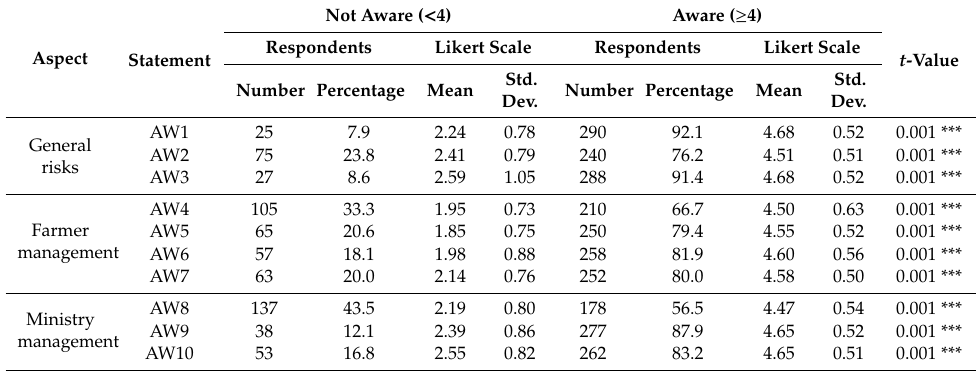
Table 5. Comparison of mean values of farmers who were not aware and aware in each statement of